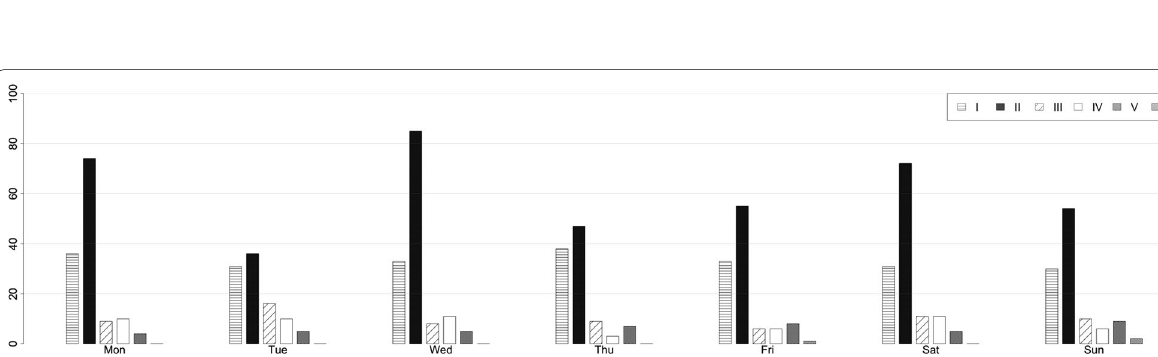
Fig. 4 Distribution of trauma mechanisms according to the days of the week. I, low-energy trauma that occurred in a public place; II, low-energy trauma that occurred at home; III, sports trauma; IV, high-energy trauma resulting from car and pedestrian accident; V, work-related injuries; VI, trauma resulting from assault, beatings, or